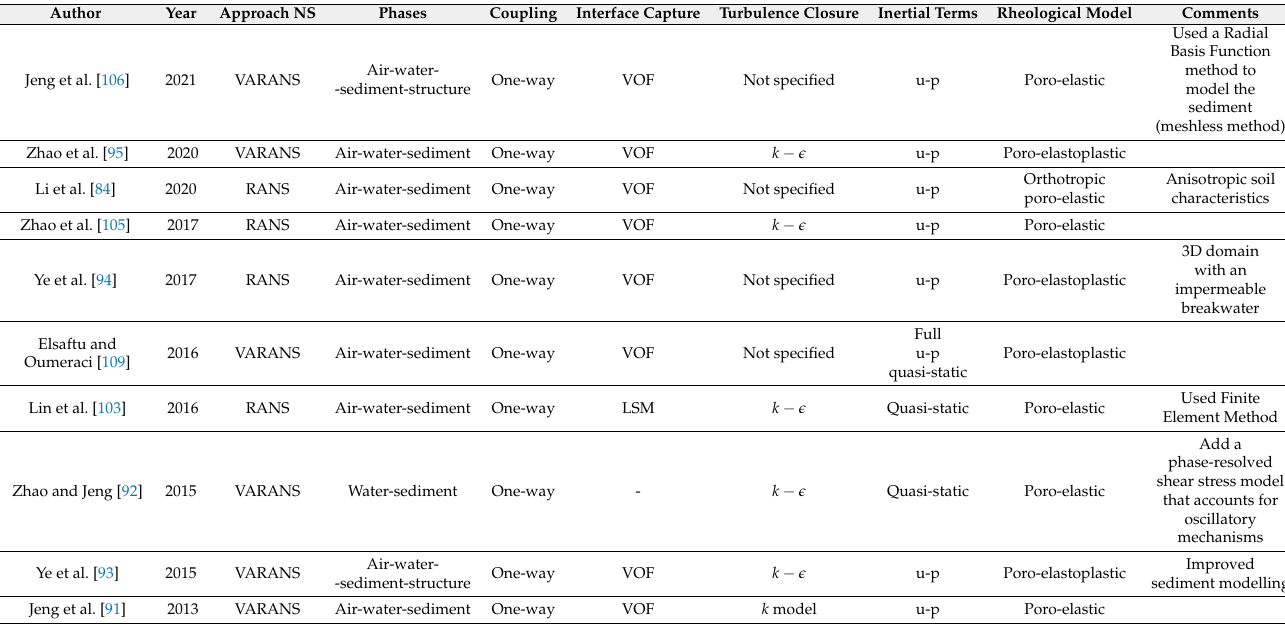
Table 2. A summary of the most recent and leading works that use the RANS–Biot approach to model the wave–structure- seabed